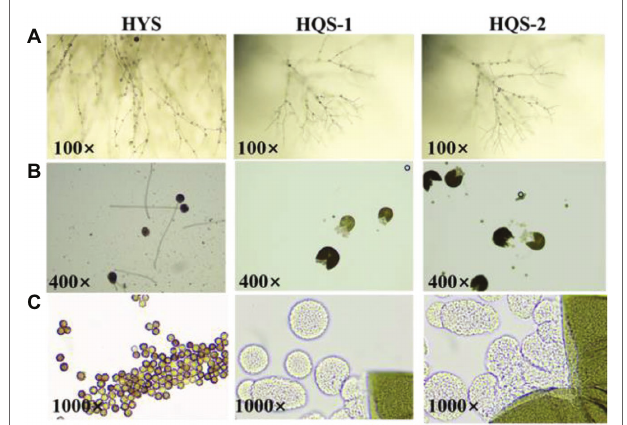
FIGURE 2 | Microscopic morphology of strains HYS, HQS-1, and HQS-2, respectively. Mycelia and spore morphology observed under light microscope (100×; A ). Conidium and mature ascoma morphology observed under light microscope (400×; B ). Conidiospore and asci morphology observed under oil lens (1000×; C